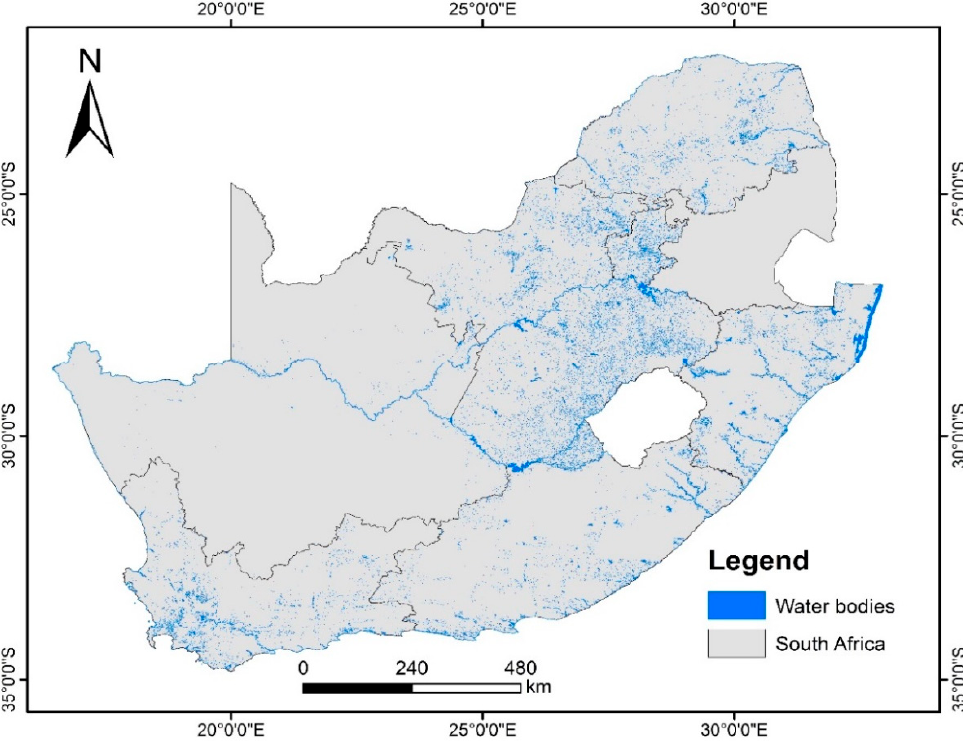
Figure 8. The National Waterbody Layer derived from Landsat 8 images acquired between December 2018 and February 2019.